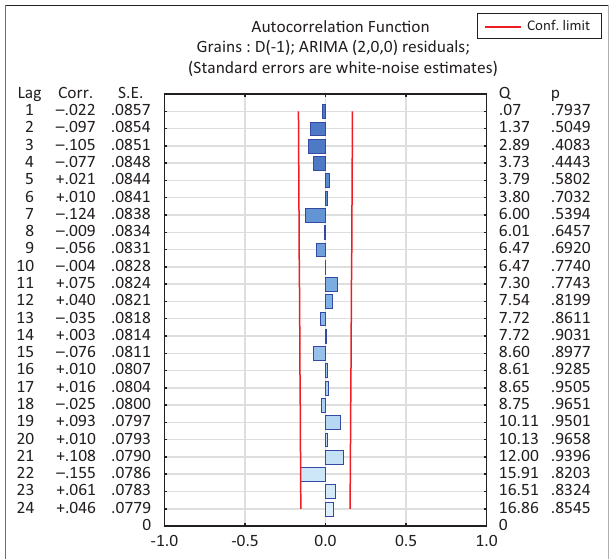
FIGURE 6: Autocorrelation function for grains for the chosen model.